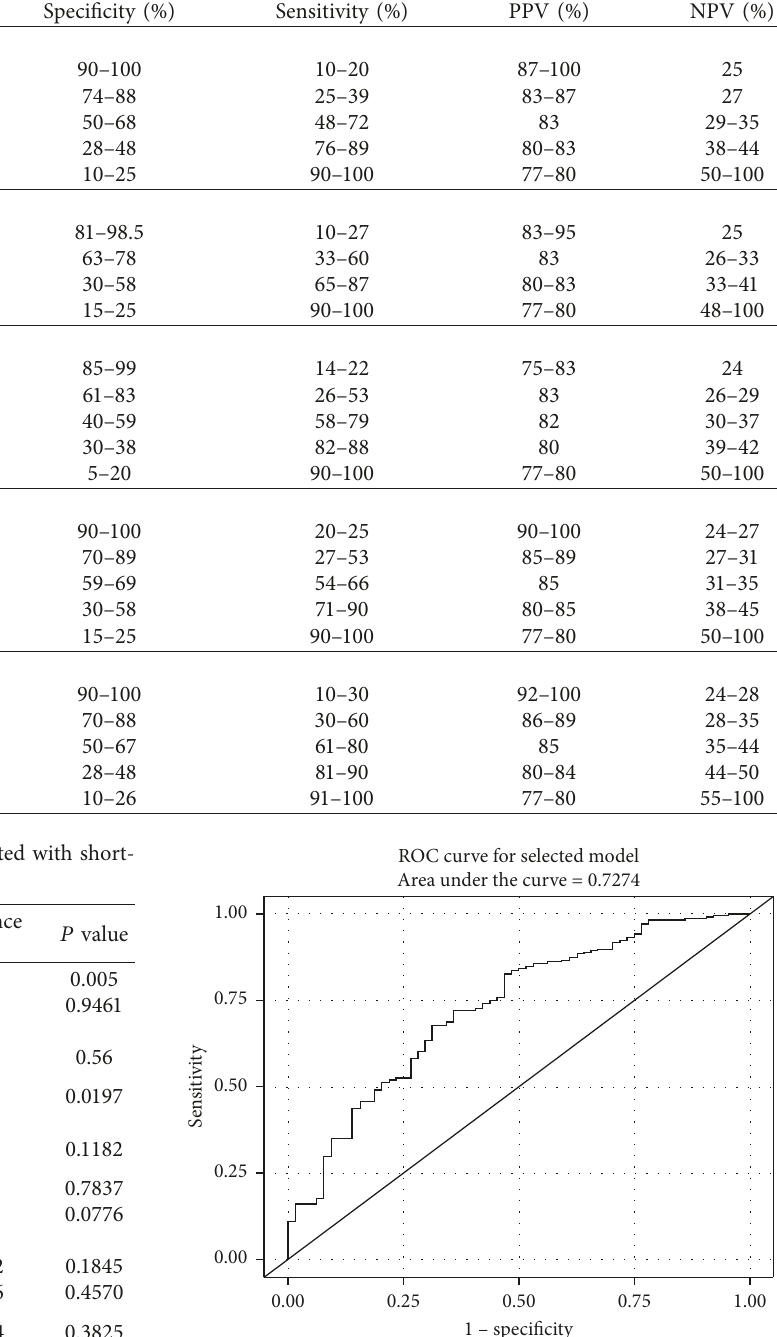
Table 3: Specificity, sensitivity, PPV, and NPV of several cutoff point values according to ROC curve analysis for short-term mortality and long-term survivals.